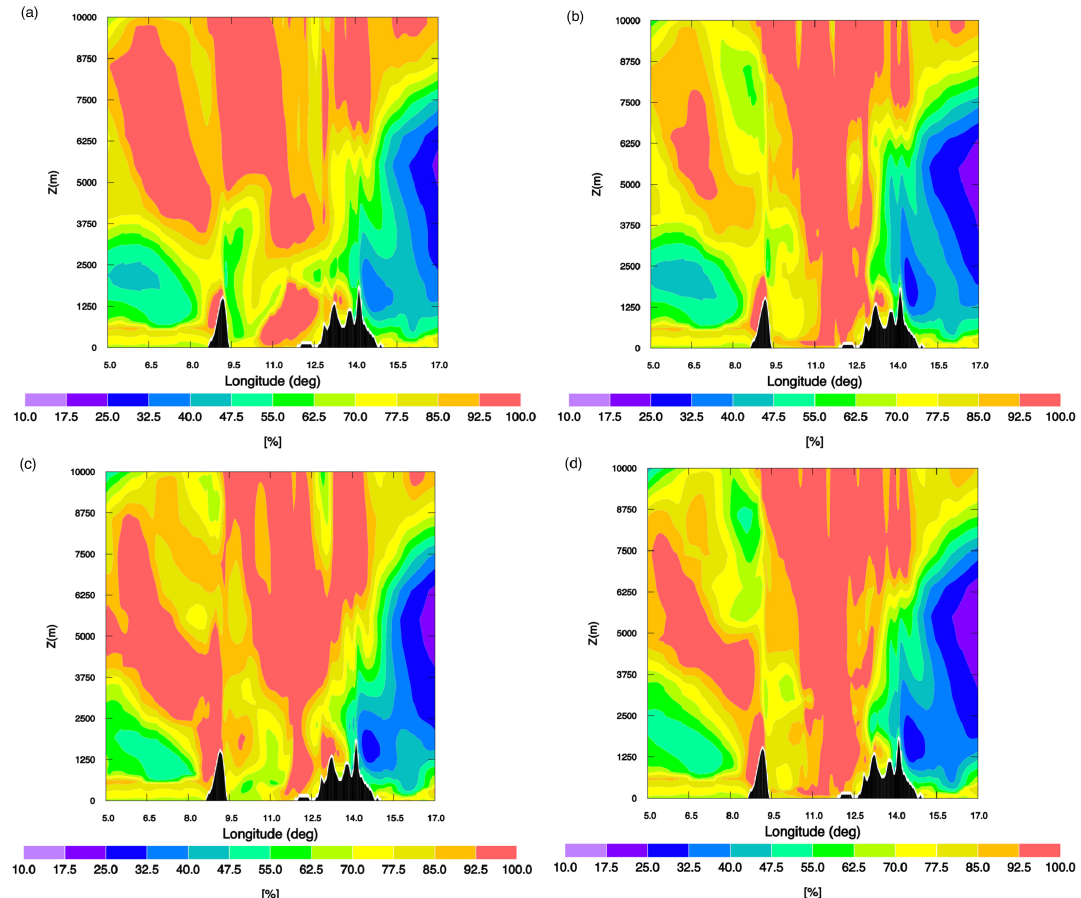
Figure 19. Relative humidity longitude–height cross section at 42 ◦ N and at 06:00UTC on 10 September 2017 for (a) CTRL, (b) RAD, (c) LIGHT, and (d) RADLI. Only the longitude range between 5 and 17 ◦ E and the vertical range between 0 and 10km are shown for clarity.